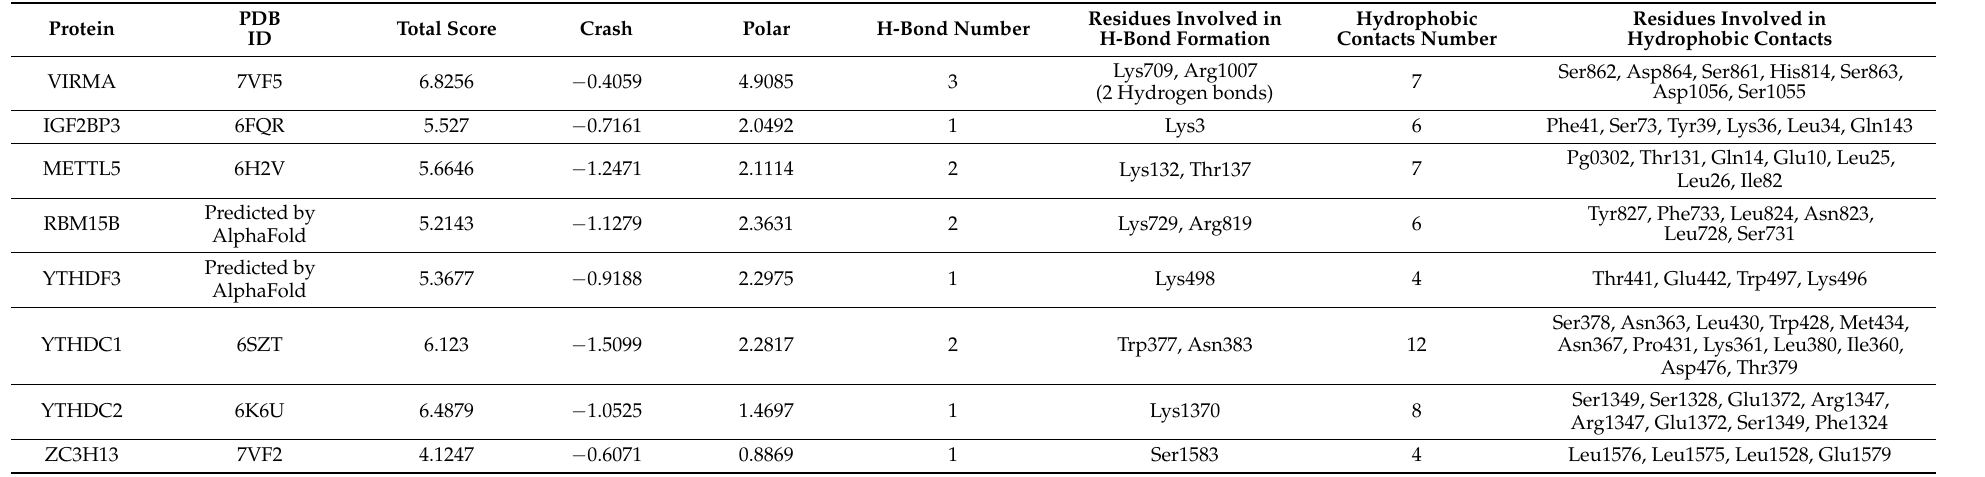
Table 2. The predicted interactions between AFB1 and m6A